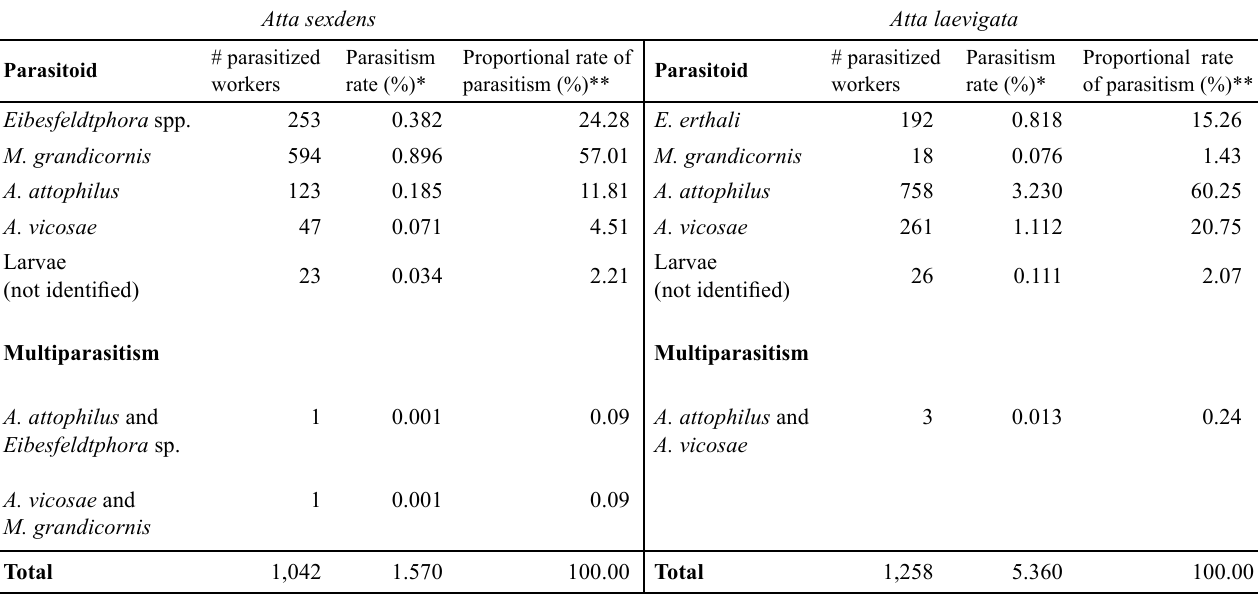
Table 1 . Numbers and percentages of workers of two Atta leaf-cutter ant species parasitized by three genera of Phoridae flies ( Eibesfeldtphora , Apocephalus and Myrmosicarius ) in the central region of the State of Tocantins, Brazil. A total of 66,226 workers of A. sexdens and 23,473 of A. laevigata was collected. The larvae were found inside the bodies of the hosts during dissections. Five workers revealed cases of